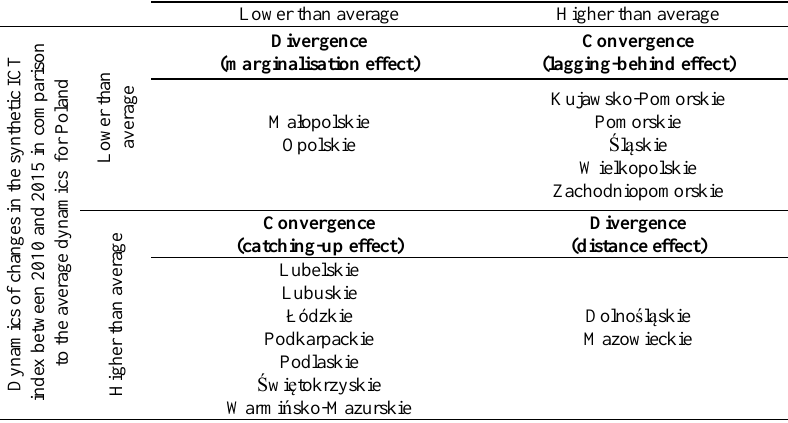
Table 2. Character of processes occurring in provinces with respect to the information infrastructure between 2010 and 2015 Synthetic ICT index in 2010 in comparison to the average value for Poland Lower than average Higher than average Divergence (marginalisation effect)